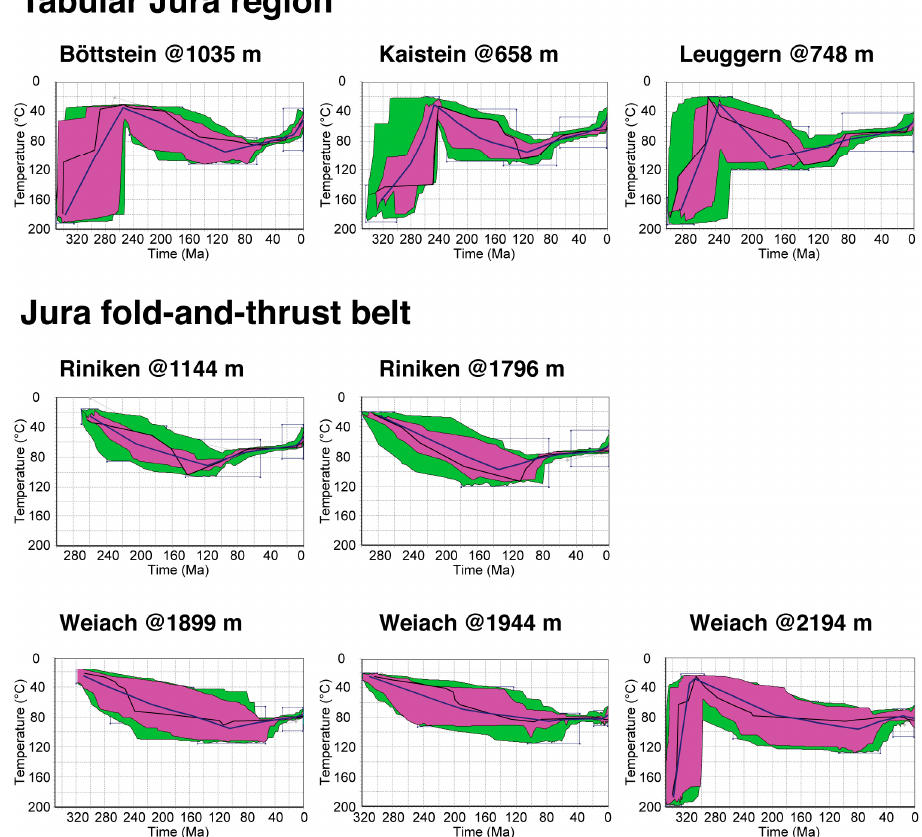
Figure 5. Thermal history models for the different regions. Eight samples were modeled using the software HeFTy ® (version 1.9.3). Input data included AFT age, track length data, and Dpar (a proxy for chemical composition). The thermal constraints in the time–temperature window for the inverse modeling are (i) basement rocks required to be at surface levels by Late Permian–Early Triassic times, and (ii) present-day (time = 0 Ma) temperature calculated by the total depth (TD) of the sample and the assumed present-day geothermal gradient (see Table 1). Note similar thermal models’ patterns for samples from the same well located at different depths. The best-fitting and the weighted mean paths are shown as solid dark blue and black lines, respectively. The good-fit envelope of solutions (all solutions with a goodness of fit of 0.5 and higher) are shown in pink. Acceptable solutions (goodness of fit between 0.05 and 0.5) are shown in